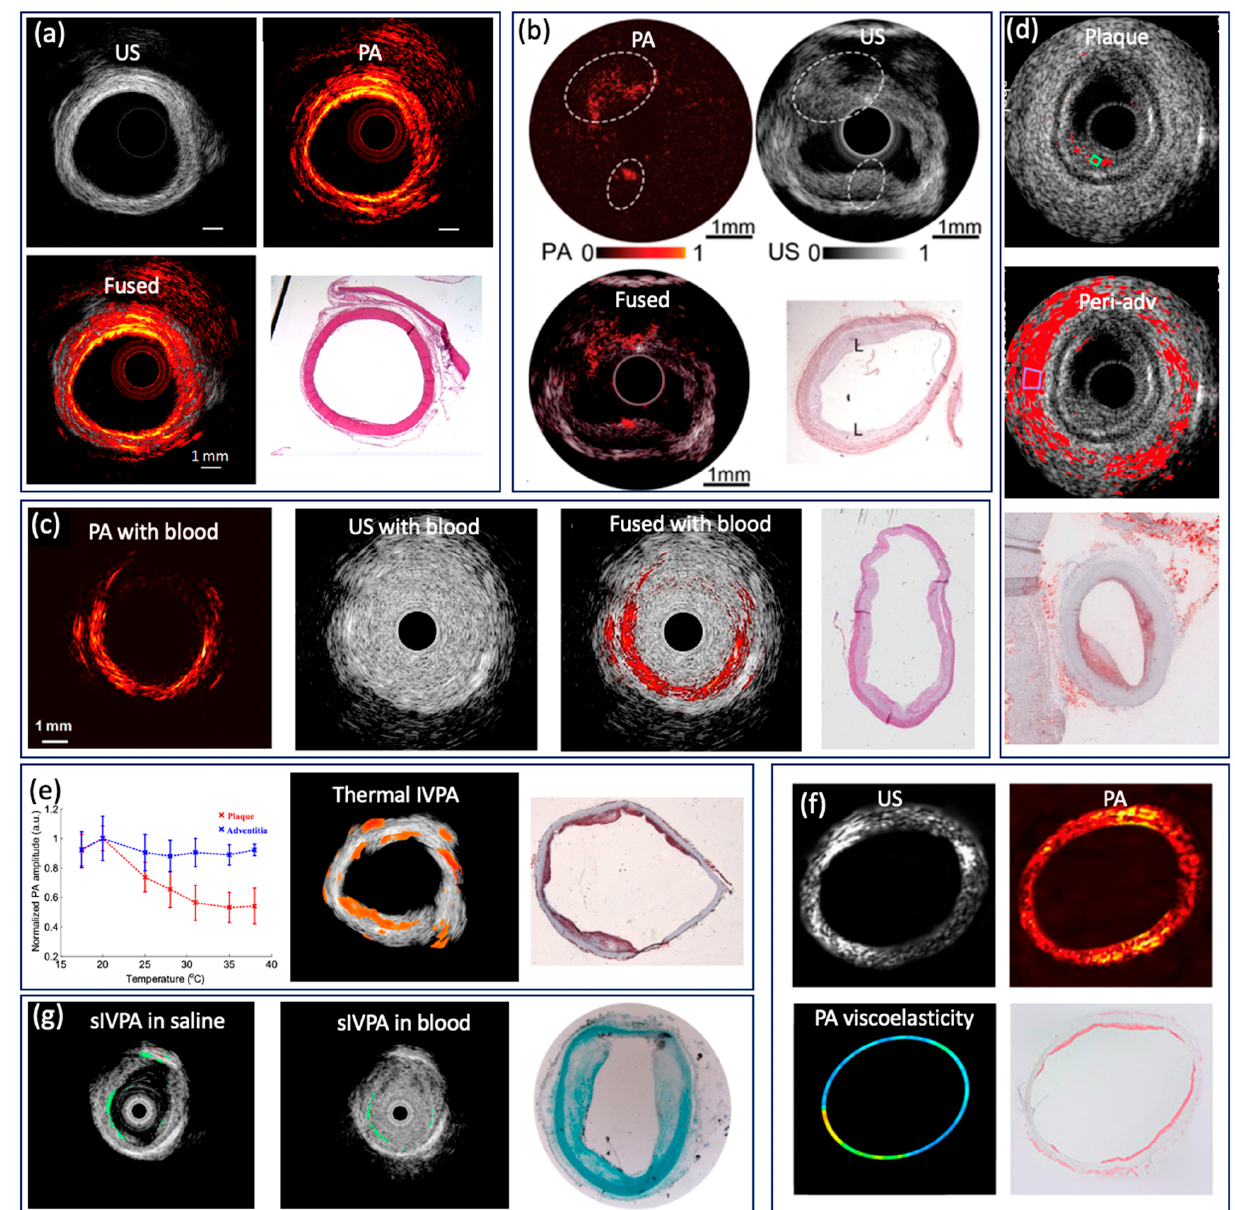
Figure 7. ( a ) PA/US image of rabbit aorta based on 532 nm pulsed laser. Adapted from [53]. ( b ) PA/US image of rabbit aorta based 1725 nm pulsed laser. Adapted from [24]. ( c ) IVPA/IVUS imaging of atherosclerotic rabbit aorta in the human RBCs solution. Adapted from [91]. ( d ) Atherosclerotic and peri-adventitial lipids map from human coronary artery based on wavelength correlation. Adapted from [35]. ( e ) Thermal IVPA images of atherosclerotic rabbit aorta. Adapted from [132]. ( f ) PA, US, elasticity images of rabbit aorta. Adapted from [56]. ( g ) Spectroscopic IVPA image of gold nanorods. Adapted from [133].